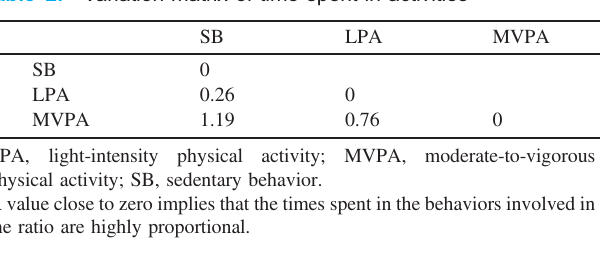
Table 2. Variation matrix of time spent in activities